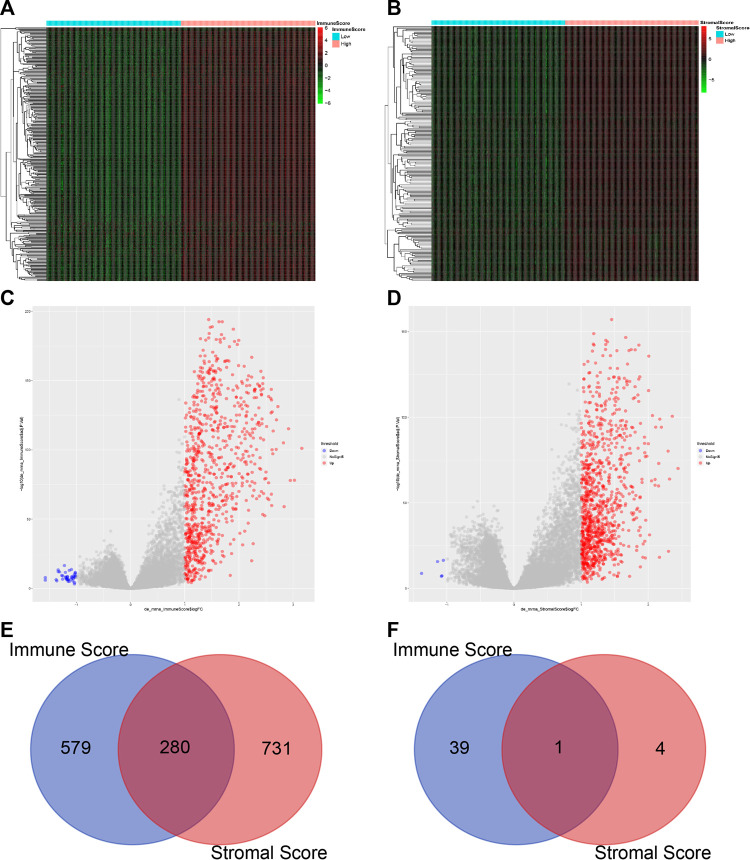
Comparison of gene expression profiles in high vs. low Immune or Stromal scores (A) Heatmap of the DEGs in the Immune score of high vs. low. Genes upregulated are displayed in red; genes downregulated are shown in green. Genes with no change are in black (p < 0.05, FC > 2). FC, fold change (B) Heatmap of the DEGs in Stromal score of high vs. low (p < 0.05, FC > 2) (C–D) Volcano plot of gene expression profiles in high vs low Immune or Stromal scores. A total of 859 genes were upregulated and 40 genes were downregulated in the group of high Immune score (FC > 2, p < 0.05). Similarly, there were 1,011 upregulated genes and five downregulated genes in the high Stromal score group (FC > 2, p < 0.05) (E–F) Venn diagrams display the number of commonly upregulated (C) or downregulated (D) DEGs in the high Immune or Stromal score groups.